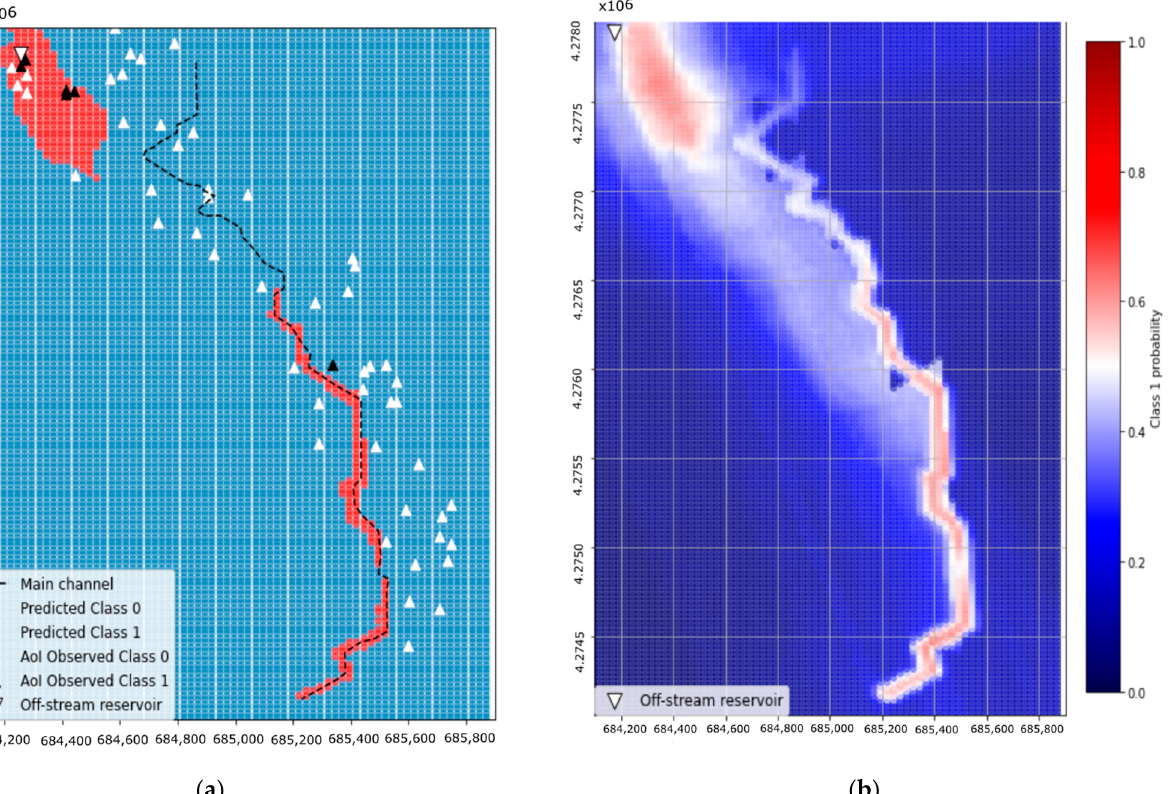
Figure 20. Results of the RF model: ( a ) prediction classification of risk with the ML model for the area of study; ( b ) probability of Class 1 for the area of study predicted by the ML model.